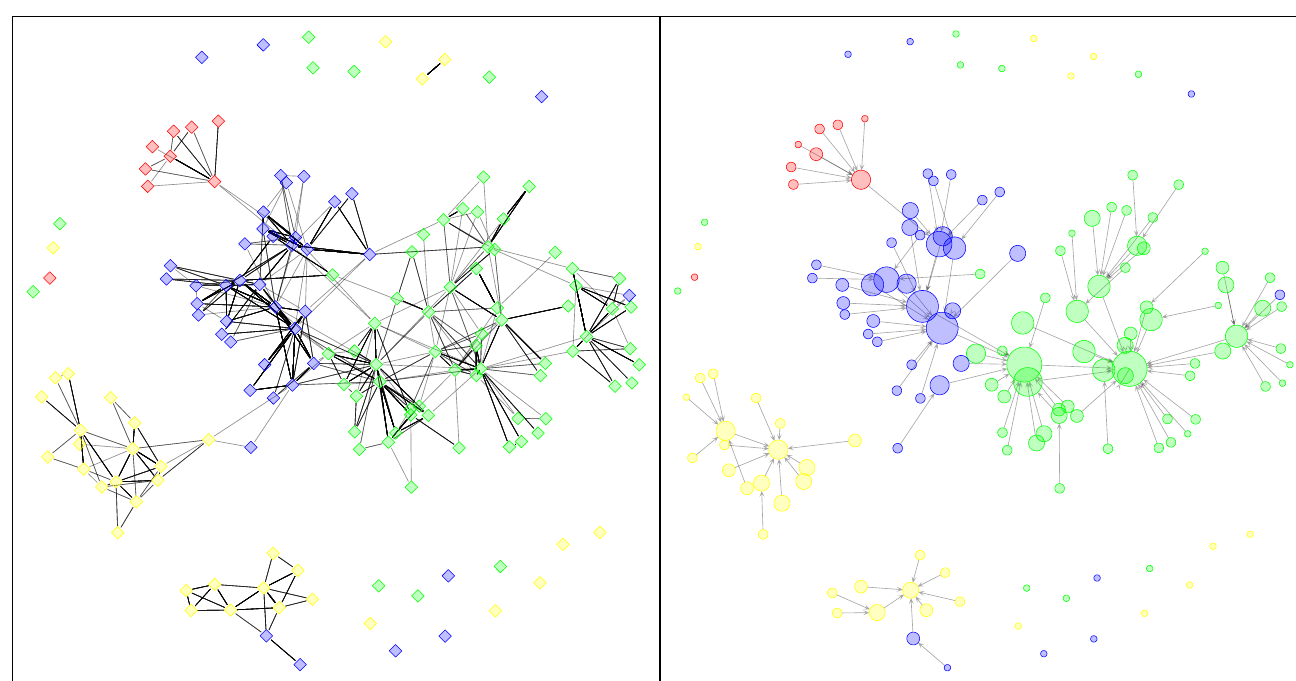
Figure 7. Left : Forest of the co-authoring in a laboratory. Each vertex is one researcher and each edge corresponds to one common publication. Right : Representative Network. The higher is the score of one researcher, the higher is the diameter of its vertex in the graph. In this graph, each edge is the link of one researcher to its